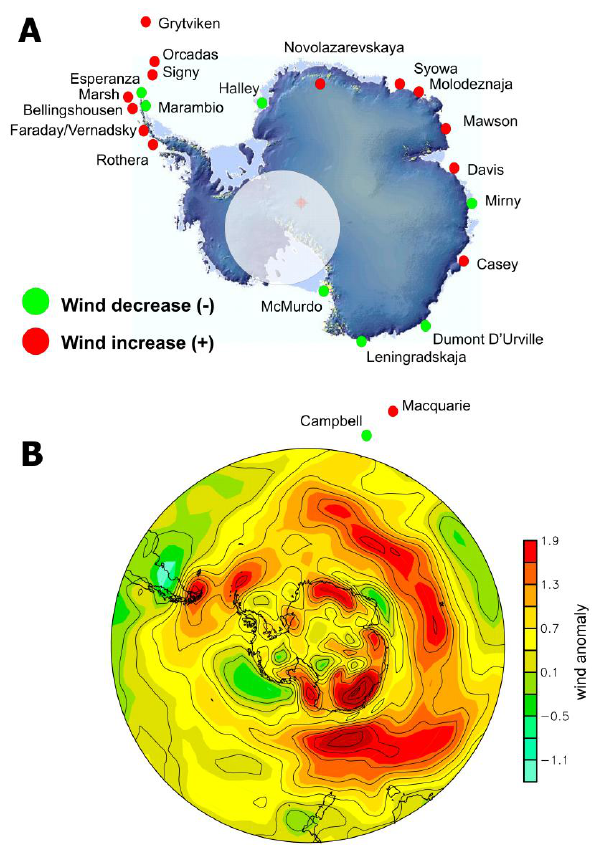
Fig. 2. (A) Surface wind trends from Antarctic stations before and after 1979 (see Table 1); and (B) for comparison, simulated wind anomaly by NCEP-NCAR reanalysis relative to 1979 at 925hPa.